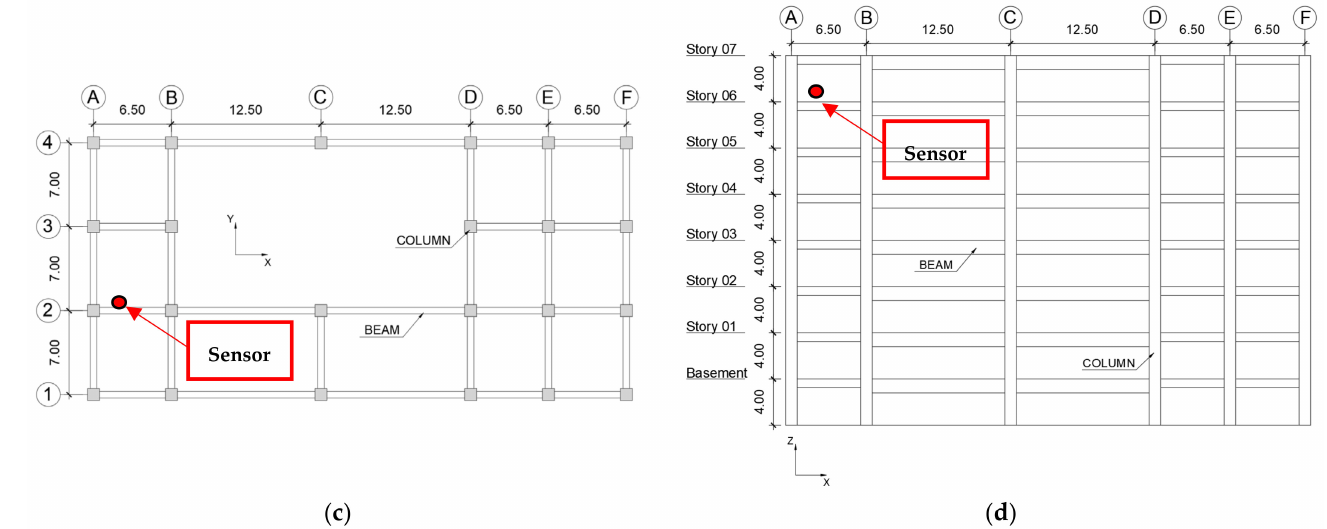
Figure 5. General drawings of Toyohashi Fire Station building. ( a ) Plan of basement view. ( b ) Plan from 1st to 6th storey view. ( c ) Plan of 7th storey view. ( d ) Elevation of X-direction view.